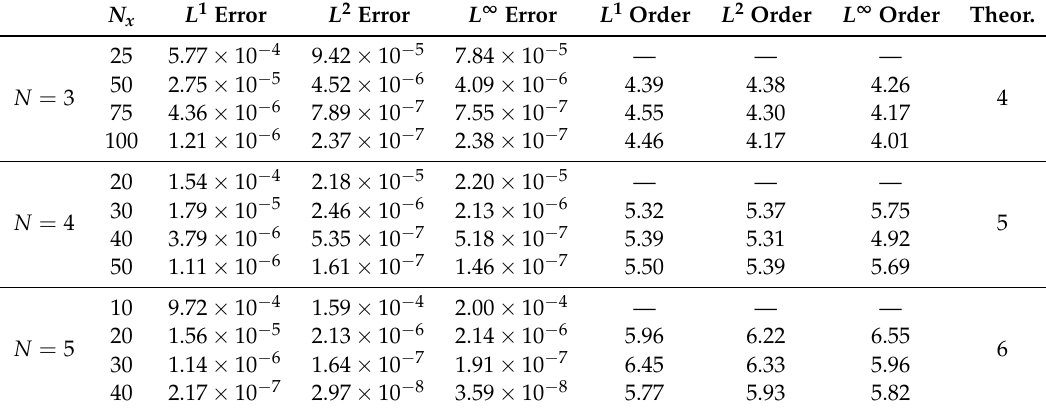
Table 1. L 1 , L 2 and L ∞ errors and numerical convergence rates obtained for the two-dimensional isentropic vortex test problem using different unlimited ADER-DG schemes, see Reference [36].